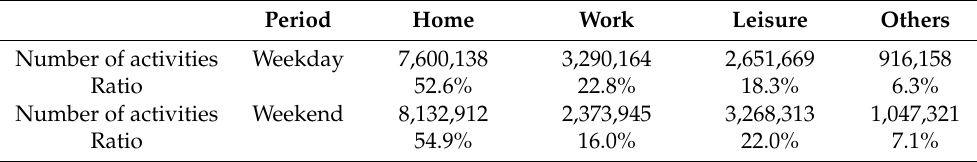
Table 4. Recognition results of the number and proportion of urban human